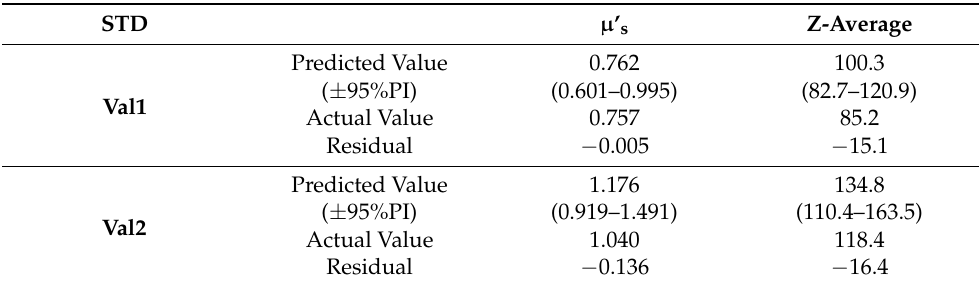
Table 4. Actual vs. predicted values (with low and high 95% prediction interval (PI) with alpha = 0.05) and corresponding residuals for the validation points Val1 and